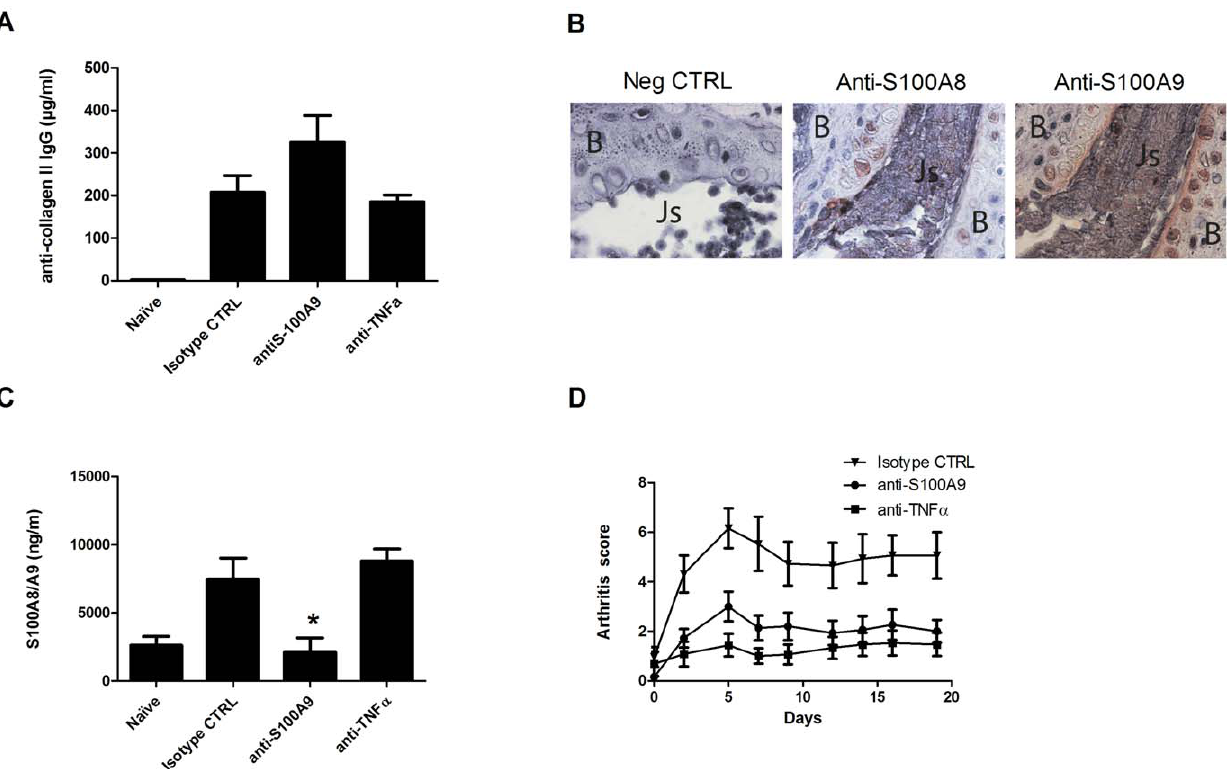
Figure 2. Effect of anti-S100A9, TNF a , or isotype control Abs on the LPS-CIA clinical score. (A) Anti-collagen II Abs were measured in mouse serum 4 h after LPS injection. The results are expressed as m g of IgG Ab/ml of serum. (B) S100A8 and S100A9 expression in arthritic paws. Paw tissue sections were stained with rabbit pre-immune serum, rabbit anti-S100A8, or rabbit anti-S100A9 polyclonal IgGs. B: bone, Js: joint space. (Magnification 1000X). (C) Four hours after LPS injection, sera were collected and ELISA S100A8/A9 were performed *p , 0.05, one-way ANOVA test (n=10 paws/group), Tukey’s Multiple Comparison Test (D) Clinical score as assessed by two blinded observers. Data are the mean scores calculated from at least 15 mice per group until day 19.